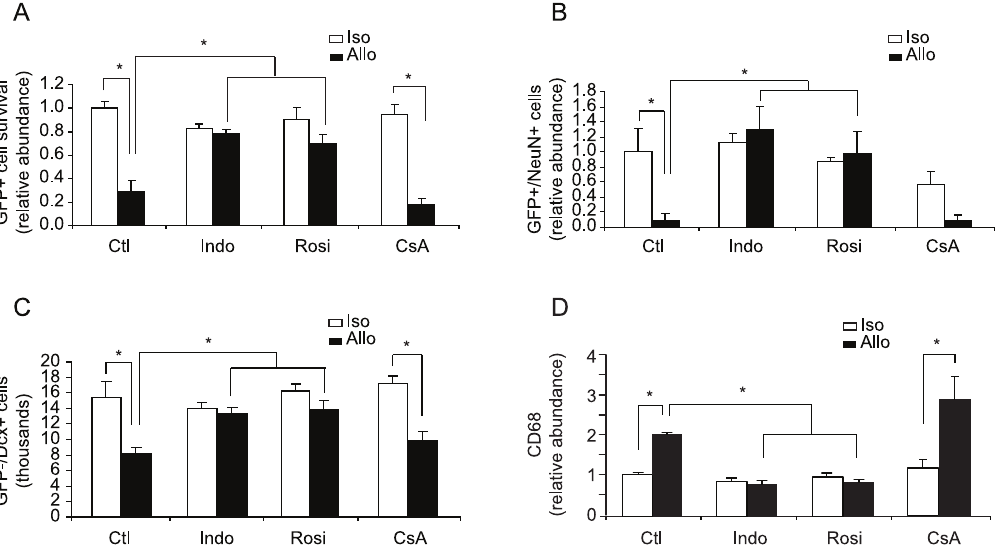
Figure 4. Treatment with NSAIDS restores neuron production in allografts. C57BL/6 GFP-positive NPCs were transplanted into C57BL/6 or Balb/c mice. Mice were administered NSAIDS (indomethacin or rosiglitazone), immunosuppressant CsA, or vehicle starting 2 days prior to transplant and continuing for two week after transplant, at which time mice were sacrificed and brains harvested. ( A ) Total number of GFP-positive cells was counted using unbiased stereology. The number of surviving GFP-positive cells was significantly reduced in non-treated allografts compared with non-treated isografts. Treatment with indomethacin and rosiglitazone but not CsA significantly enhanced graft survival. ( B ) The percentage of GFP- positive cells that turn into mature neurons (NeuN + ) was lower in allografts vs. isografts. Neuron production was significantly increased by NSAID treatment but not CsA. ( C ) The number of endogenous neuron precursor cells (Dcx-positive and GFP-negative) located at the DG was counted using unbiased stereology. Indomethacin and rosiglitazone but not CsA treatment significantly augmented the number of Dcx + cells. ( D ) CD68 expression was used to quantify microglial activation. Untreated allografts show significant increase in CD68 immunoreactivity compared to untreated isografts. Treatment with NSAIDS but not CsA suppressed microglia activation (* p , 0.05,